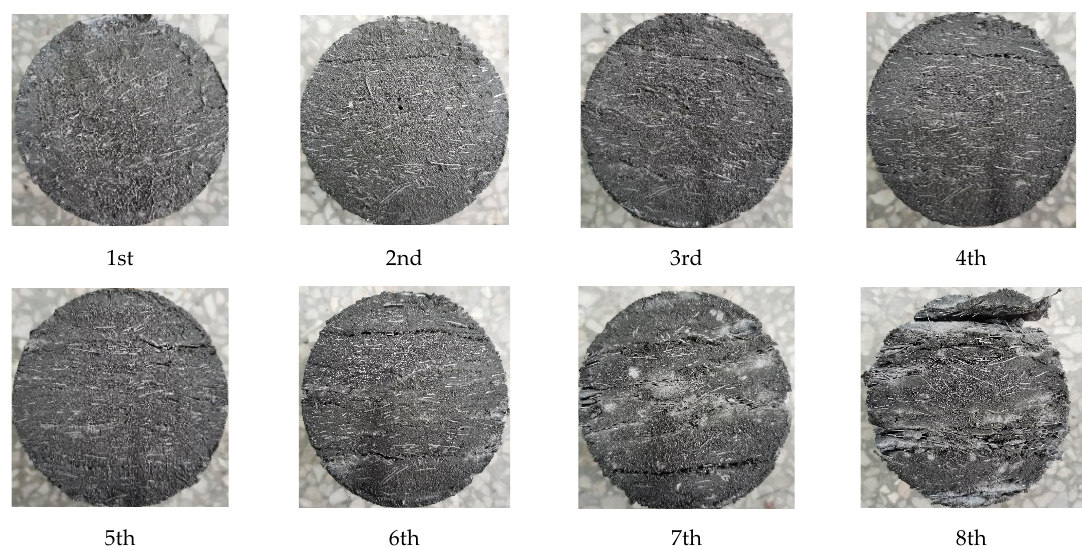
Figure 13. Fiber-oriented UHPC multiple-impact compression stress–strain curves: ( a ) D-SF2; ( b ) D-SF4; and ( c ) D-SF6.